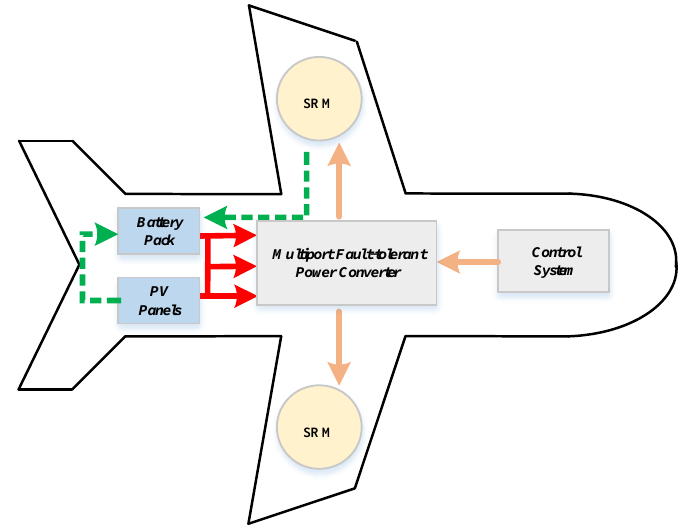
Figure 2. Photovoltaic electric aircraft drive system.